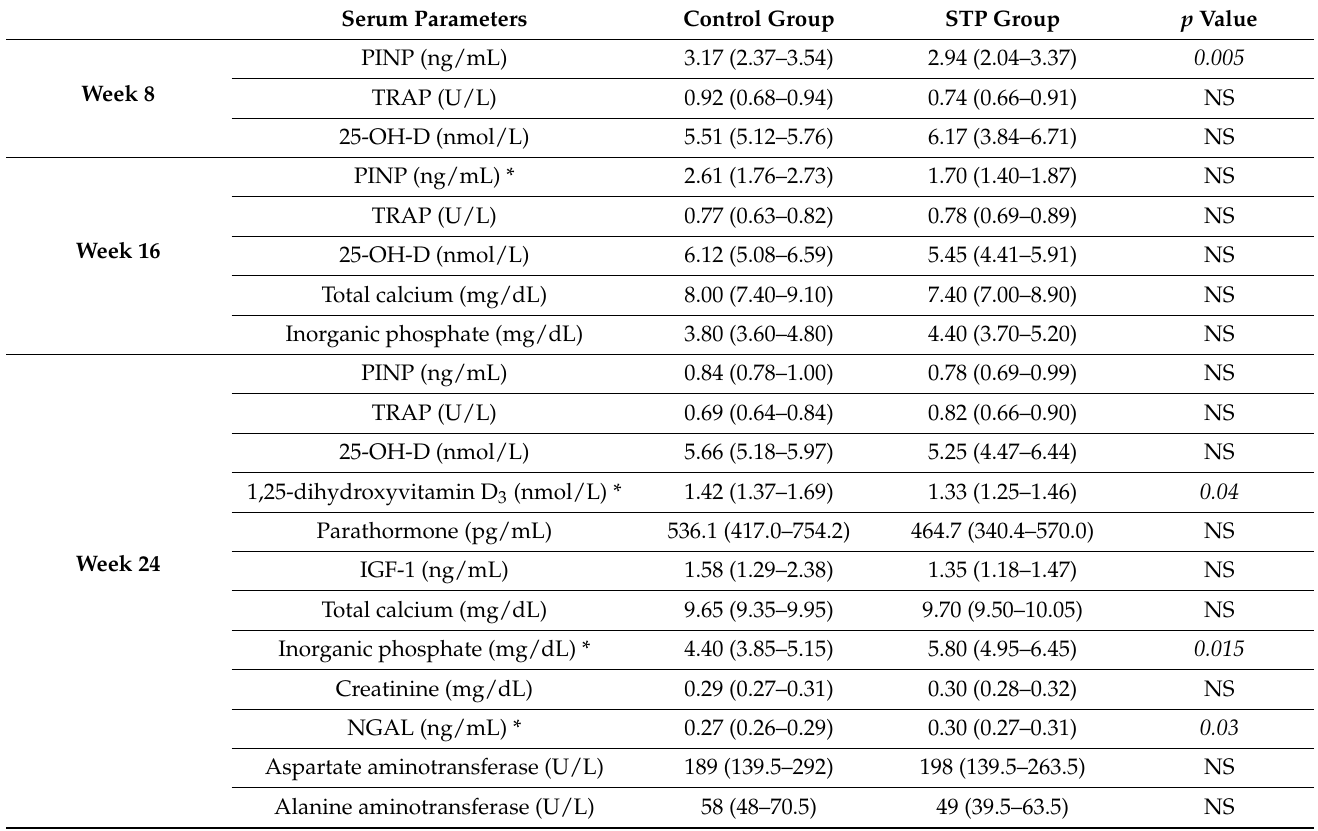
Table 1. The effect of administration of stiripentol on serum parameters (PINP-N-terminal propeptide of type I procolla- gen; TRAP—tartrate-resistant acid phosphatase form 5b; 25-OH-D-25-hydroxyvitamin D; NGAL—neutrophil gelatinase- associated lipocalin; STP group—group receiving stiripentol). Results presented as: median (lower quartile—upper quar- tile) .